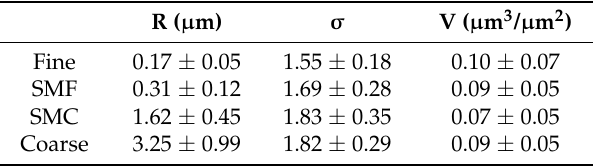
Figure 3. The average sub-mode volume size distribution in Chengdu. Table 1. The parameters of sub-mode volume size distribution.